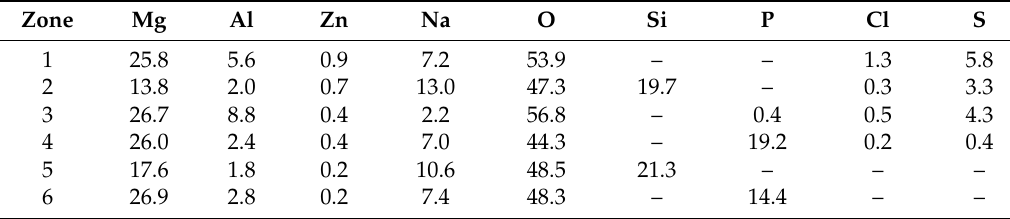
Figure 11. SEM-BSE images (backscattered electrons) of the surface of the samples after tribocorrosion test ( A ) PEO-Si; and ( B ) PEO-P; and standard wear tests ( C ) PEO-Si; and ( D ) PEO-P. Table 6. EDS microanalysis (wt %) obtained on different zones of the samples after corrosion and dry wear test.